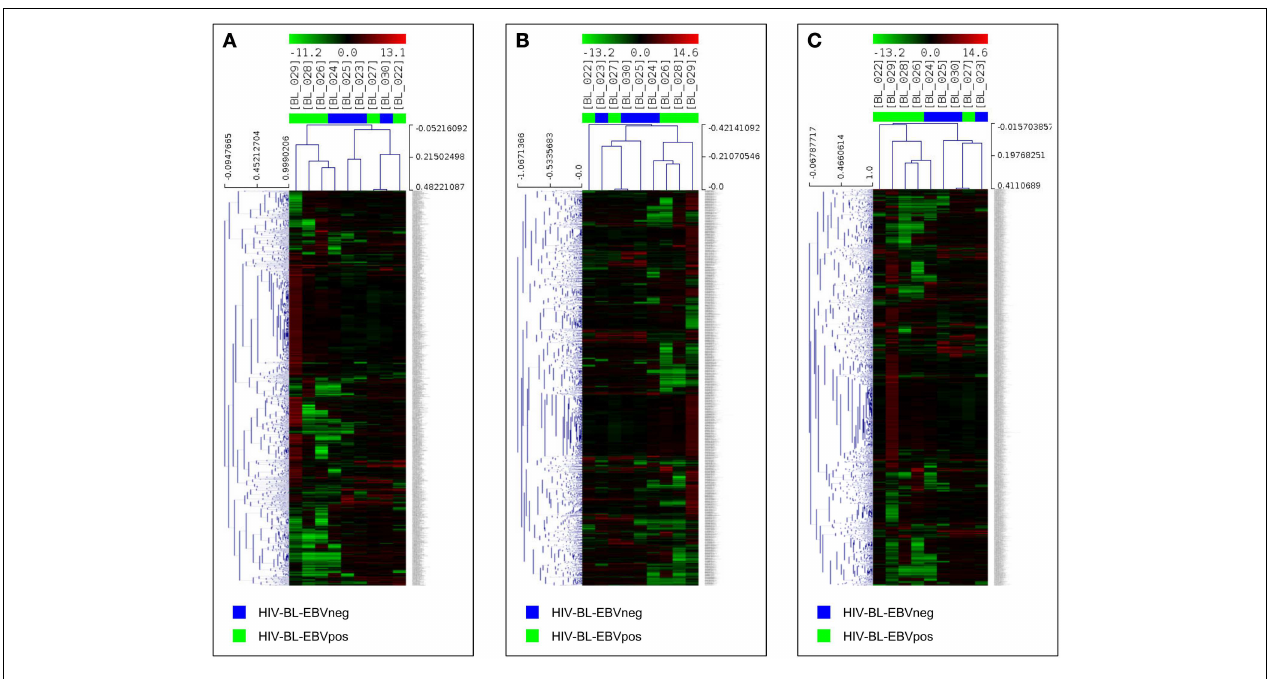
be the most effective in clustering the two groups (C) . In the matrix, each column represents a sample, and each row represents a gene. The color scale bar shows the relative gene expression changes normalized to the standard deviation (0 is the mean expression level of a given